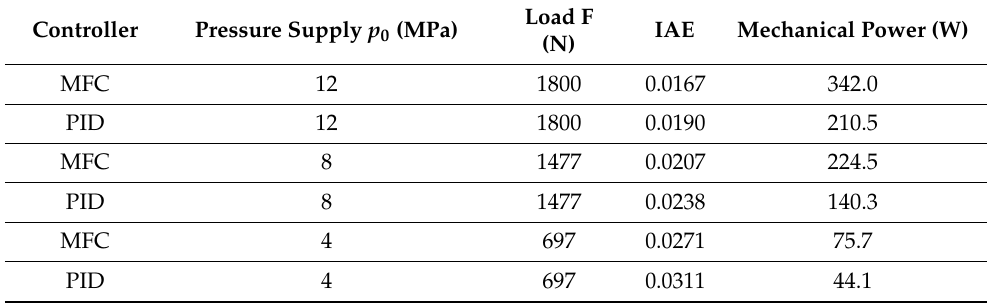
Table 2. IAE and mechanical force comparison.